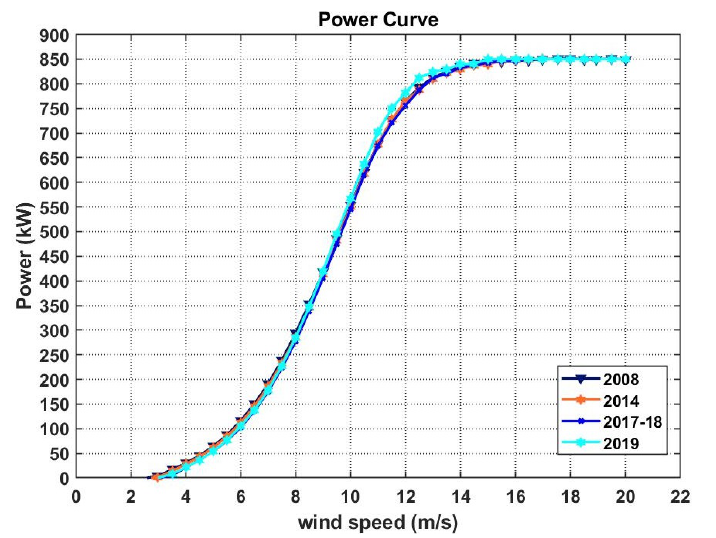
Figure 9. Power curves—2008, 2014, 2017–2018 and 2019.